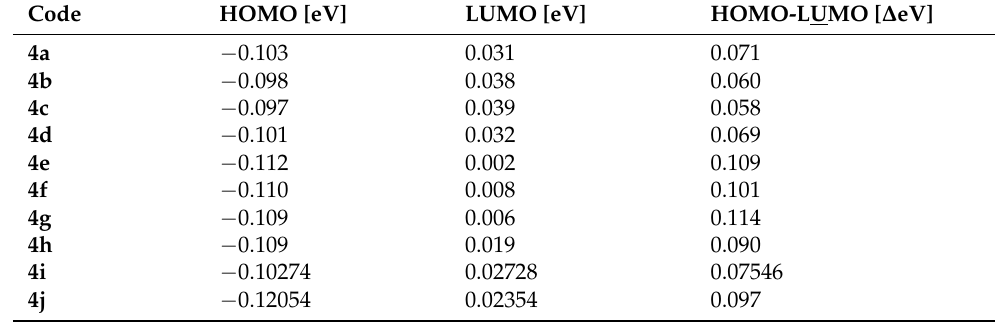
Table 3. Energy parameters of 1-aroyl-3-[3-chloro-2-methylphenyl]thiourea hybrids [ 4a – j ].